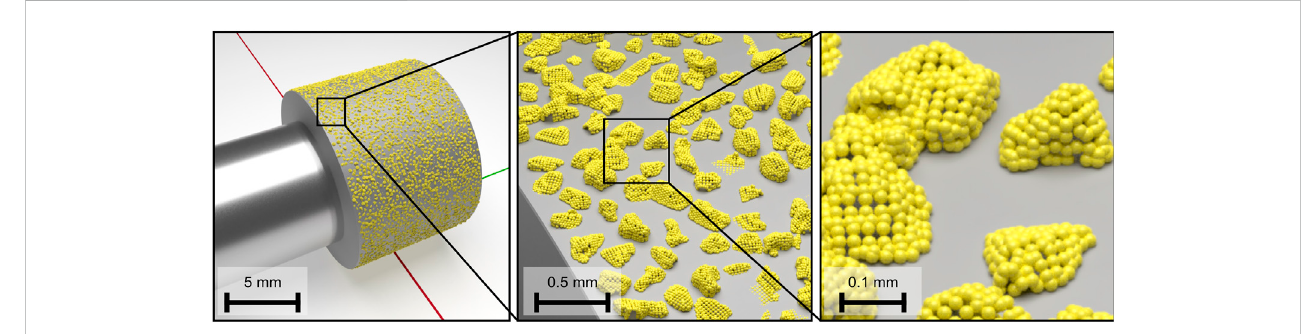
FIGURE 2 Comparison between simulated and digitized surface topographies for grinding tools with different states of wear [ cf. (Wiederkehr et al., 2018)].